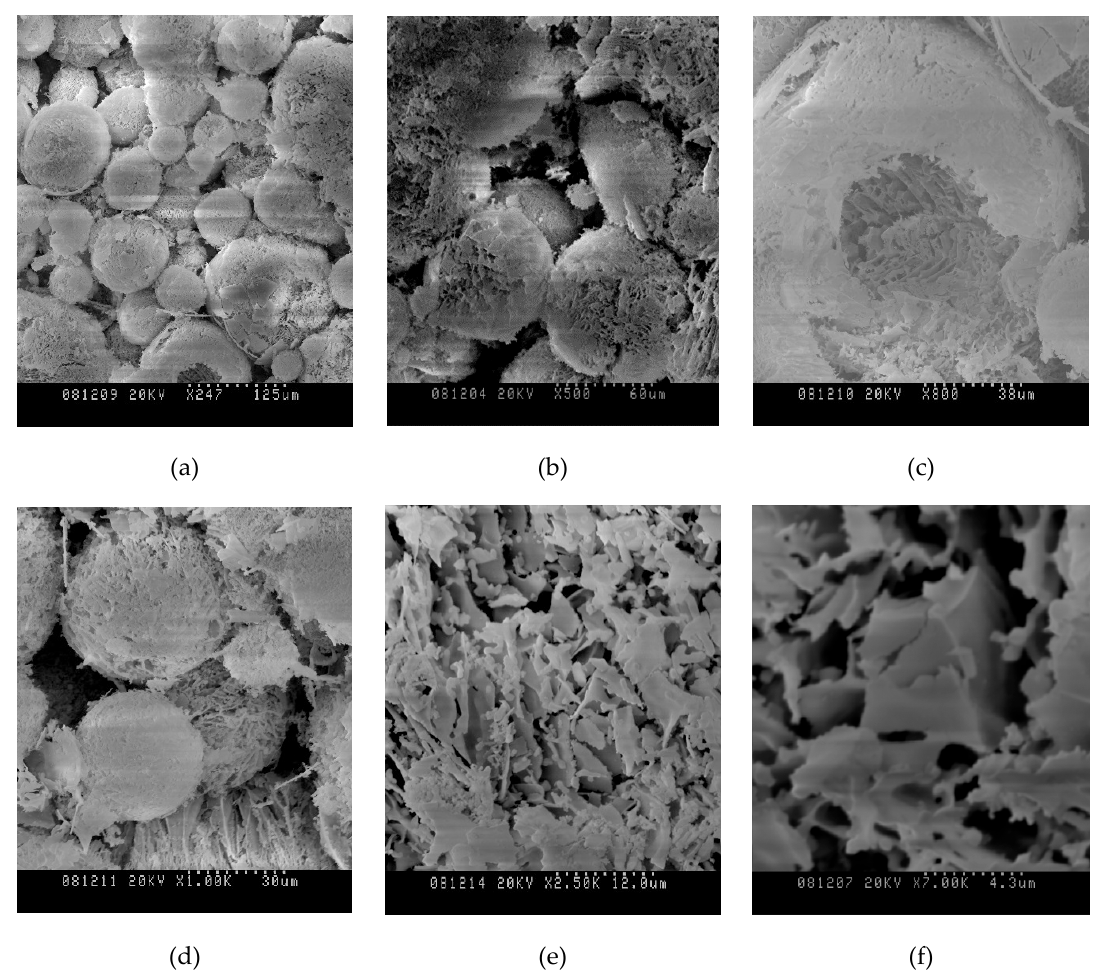
Figure 6. Images of structures from silica powder particles formed after sublimation of the solvent from cryogranules. The magnification factors on a scanning electron microscope: ( a ) 247 times; ( b ) 500 times; ( c ) 600 times; ( d ) 1000 times; ( e ) 2500 times; ( f ) 7000 times.